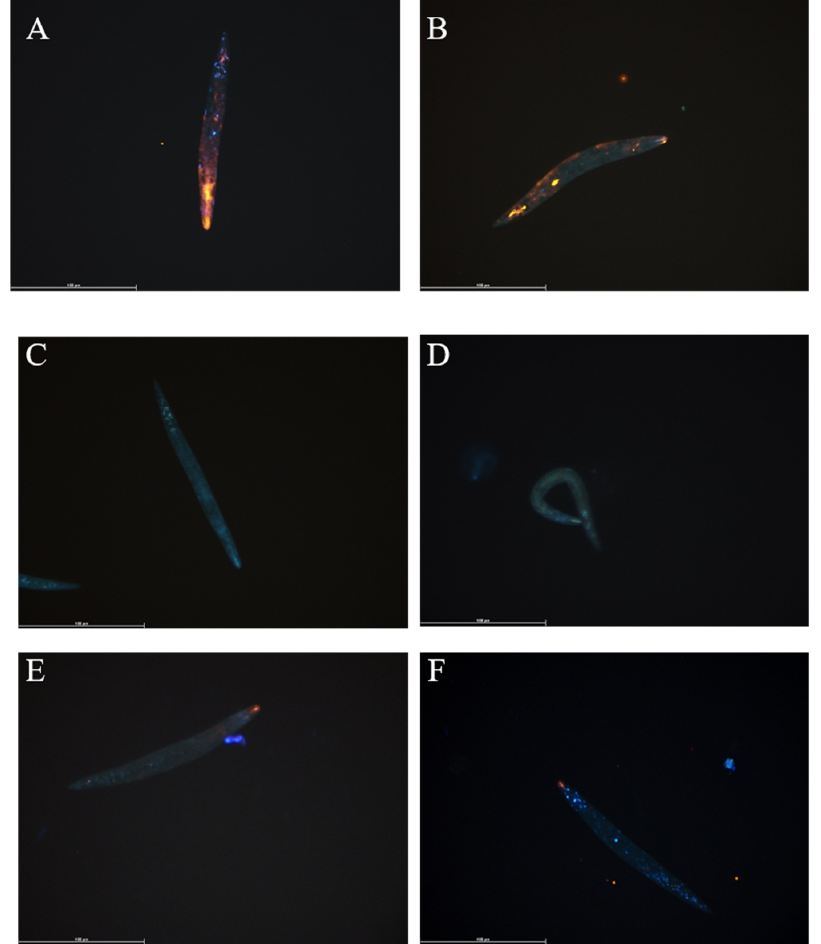
Figure 1. Hatched T. suis (L1) cultured for 4 h in the presence of 4 µM DOPE-Rho ( A,B ), control media ( C,D ) and dead T.suis (L1) cultured in 4 µM DOPE-Rho ( E,F ) prior to washing, fixation with 4% paraformaldehyde and analysis using fluorescence microscopy. Orange = Rhodamine, Blue = Hoechst nuclear stain, Scale bar: 100 µm .